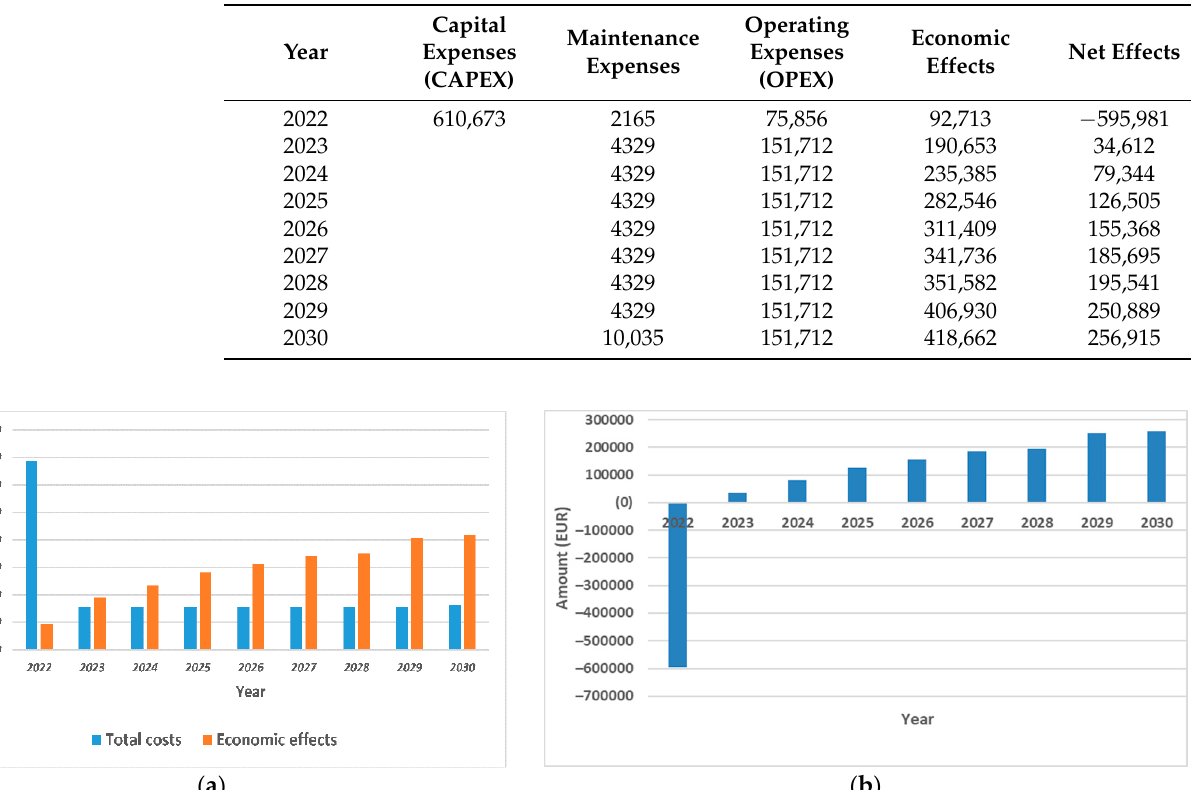
Table 13. Net effects balance projection (in EUR).